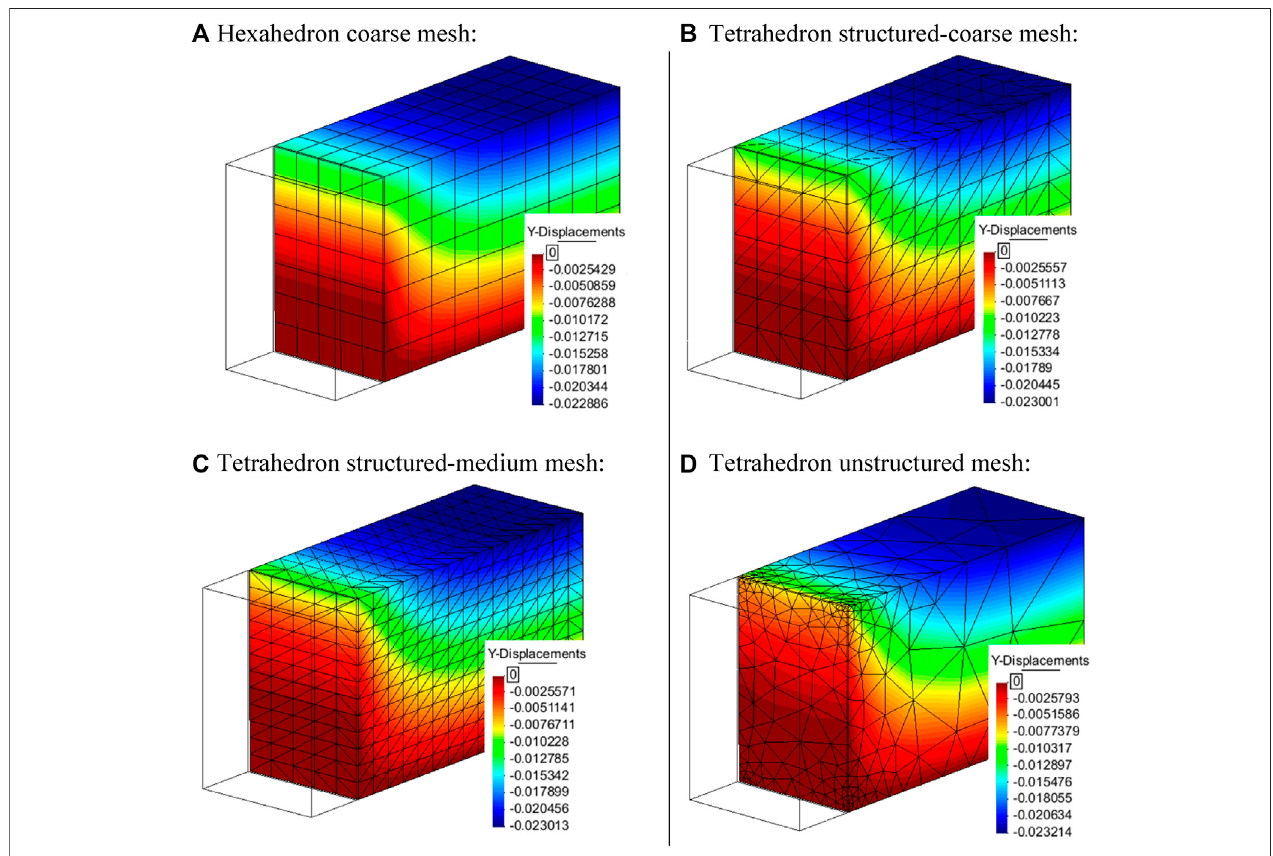
FIGURE 16 | Settlement results (units in meters) under q = 100-kPa surcharge at top of soil zone: (A) hexahedron structured-coarse mesh, (B) tetrahedron structured-coarse mesh, (C) tetrahedron structured-medium mesh, and (D) tetrahedron unstructured irregular-mesh. Cases with ti = 0.018 m and Ri = 0.8.